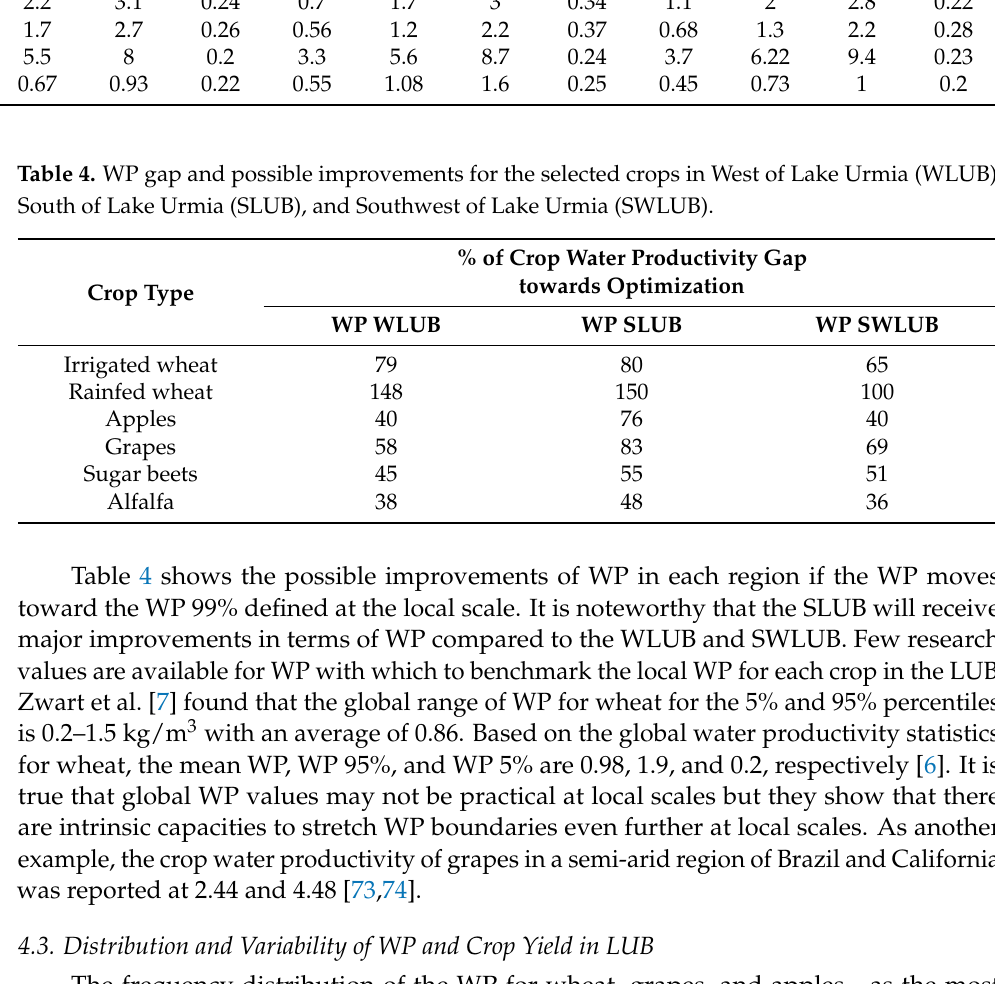
Table 4. WP gap and possible improvements for the selected crops in West of Lake Urmia (WLUB), South of Lake Urmia (SLUB), and Southwest of Lake Urmia (SWLUB).